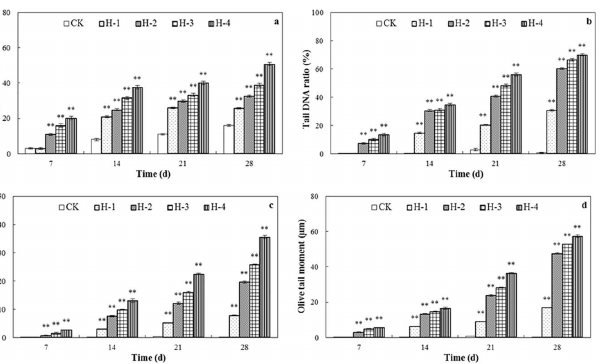
Fig 3. Geno-toxicity of DEHP determined by comet assay in the spiked soil test. (a) length of tail; (b) tail DNA ratio; (c) tail moment and (d) olive tail moment of coelomocytes in treated E . fetida after treatment for 7, 14, 21 and 28 d in spiked natural soil; CK, H-1, H-2, H-3, and H-4 (n = 4; error bars, SEM). Lengthof tail (TL) denotestail length in arbitrary units; tail DNA ratio shows relative ratio of DNA in the comet tail; tail moment (TM) represents the integrated value of DNA density multiplied by the migration distance; and Olive tail moment (OTM) is the product of the distancebetweenthe center of gravity of the head and the center of gravity of the tail and percent tail DNA. Refer to Fig 1 for other annotations (S1 Data).